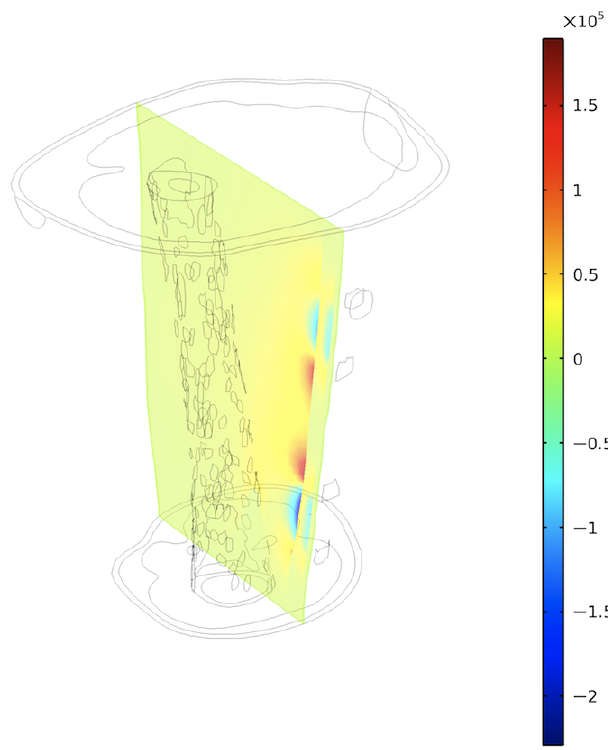
Fig. 28: Slice plot of sensitivity inside the thigh.